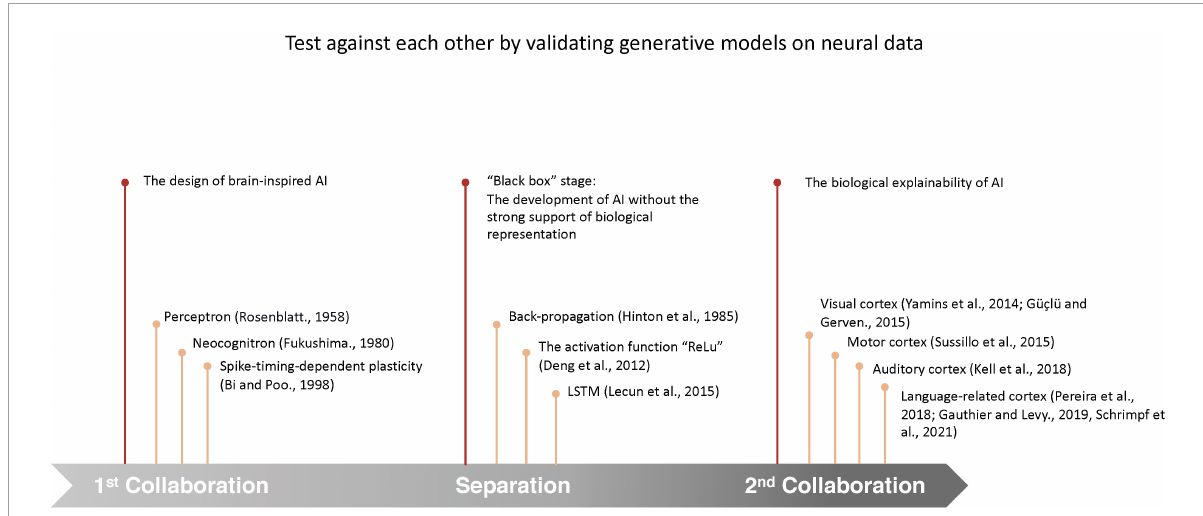
FIGURE1 Timeline of the development of the interaction between neuroscience and AI. During the development, the interaction between neuroscience and AI has experienced 3 stages: (1) neuroscience guided the design of AI models; (2) implementations of engineering and mathematical tools instead of neurobiological principles in the development of AI models have led to substantial improvement in model performances, but the complex algorithms and huge parametric space behind the high performance pose a dilemma for the explanation of the underlying specific decision-making of the models, which are also called “black box” models (Arrieta et al., 2020); (3) by comparing the predicted neurobiological representation by modern AI models to the real neural processes in the brain, neurobiological explainability are provided to AI